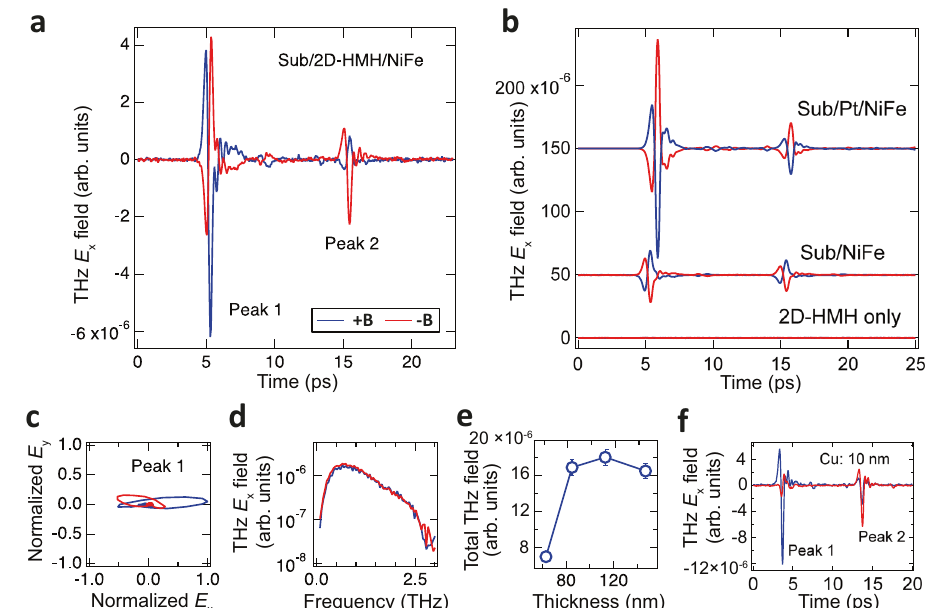
Fig. 2 Magnetic fi eld-dependent asymmetric THz radiation upon linearly polarized laser excitation. a Measured time trace of the THz pulse generated from the 2D-HMH/NiFe heterostructures under positive ( + B ) and negative ( − B ) magnetic fi elds, respectively. The forward (peak 1 at t 1 = ~5 ps) and backward (peak 2 at t 2 = ~15 ps) THz pulses exhibit opposite symmetry of the intensity depending on the direction of the applied magnetic fi eld. b Symmetric THz radiations are con fi rmed in NiFe/Pt and NiFe only control samples. No THz signal is observed in the 2D-HMH fi lm without the ferromagnet top-layer under the same laser excitation. c The parametric plot of the emitted THz fi eld shows the THz polarization is mainly along the x -direction. d The THz emission spectra of a indicate equal total THz radiation in spite of asymmetric radiation along with two propagation directions. e THz signals show a very weak 2D-HMH thickness dependence at the higher 2D-HMH thicknesses above ~80 nm. The error bars represent the standard errors of the measurements. f Pronounced asymmetric THz radiation in 2D-HMH/Cu/NiFe trilayer structure, ruling out the possible proximity effect induced nonreciprocal phenomena at the 2D-HMH/NiFe